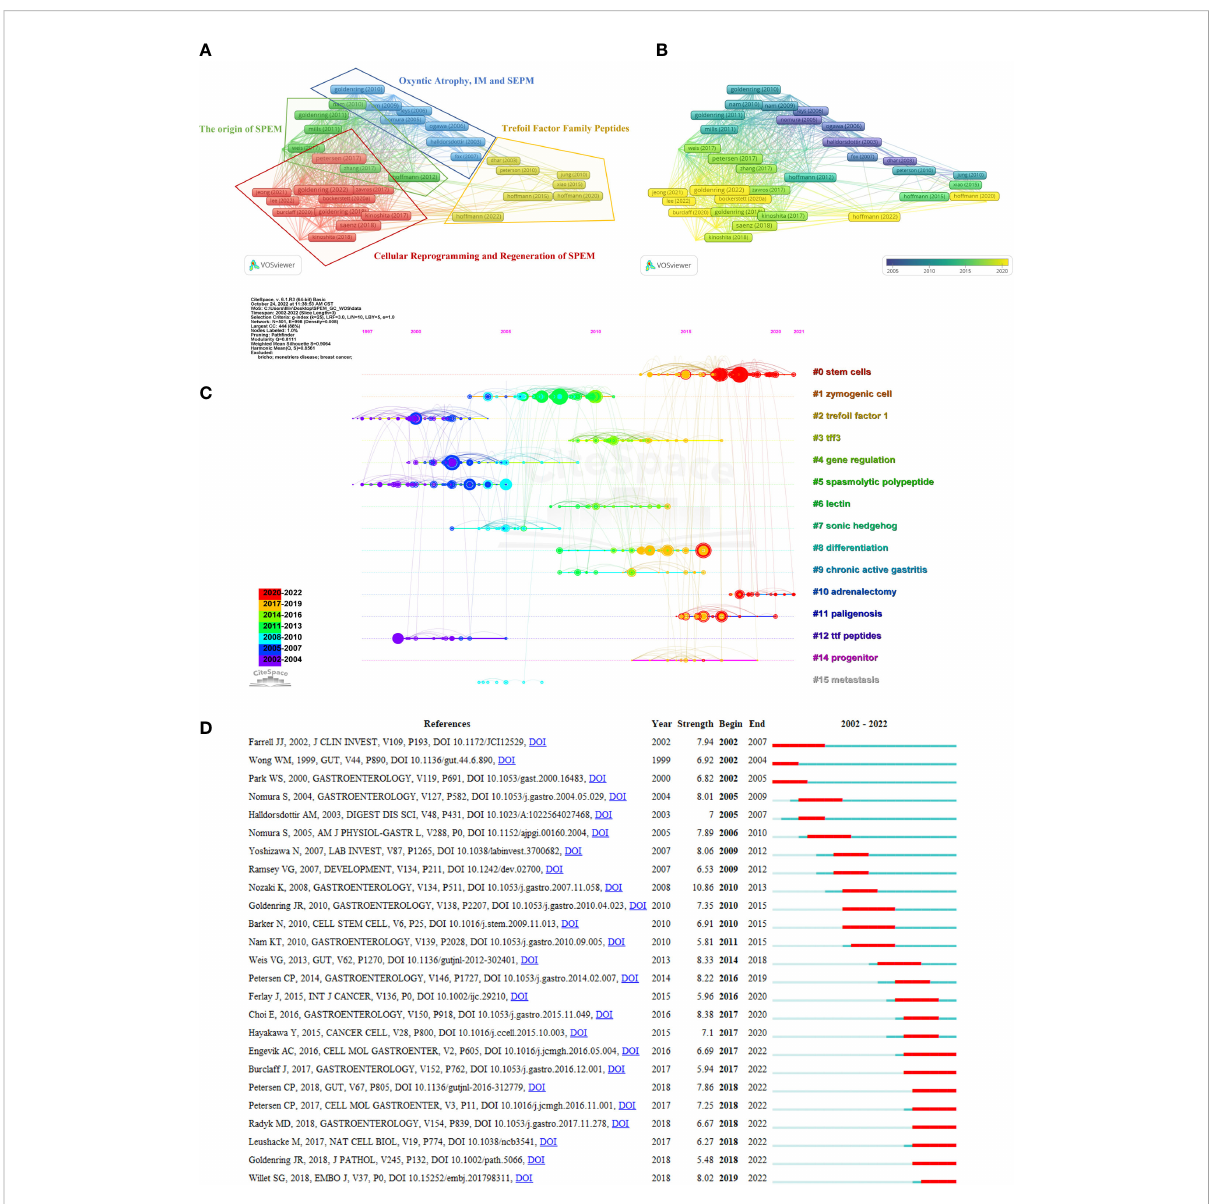
FIGURE 5 Coupling and co-citation analysis of references. (A) Top 50 highly citing references cluster map. The node ’ s size represents the strength of the references, and the link indicates the correlation between them. Each node is colored according to the cluster in which the two papers cited the same reference more frequently. (B) Time-overlay visualization map of the top 50 highly cited references. (C) The timeline shows all the co-cited references related to SPEM-GC. Each horizontal line represents a cluster, and #0 represents the largest cluster. Co-cited frequencies are re fl ected in node size, and links indicate co-citation relationships. The color of the node and line represent different years. The nodes represent their fi rst co-citation. (D) Graph showing the top 25 references with the greatest citation bursts involved in SPEM-GC (sorted by beginning year). The blue bars indicate that the reference has been published, and the red bars represent how citations have burst during the studies ’